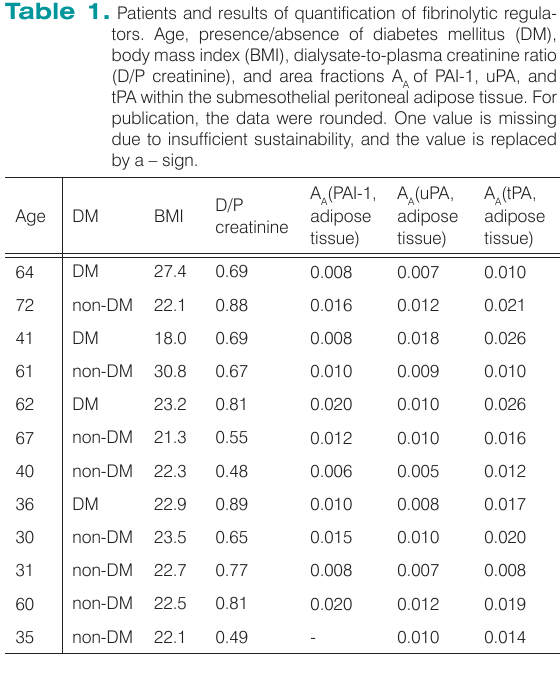
Table 1. Patients and results of quantification of fibrinolytic regula - tors. Age, presence/absence of diabetes mellitus (DM),